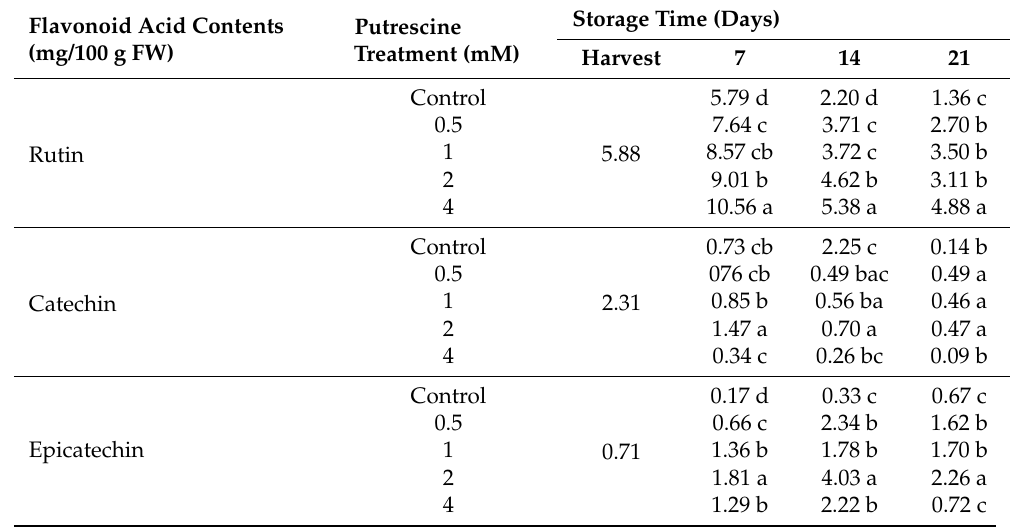
Table 2. Effect of putrescine treatment on flavonoid and contents of fig fruits during cold storage.